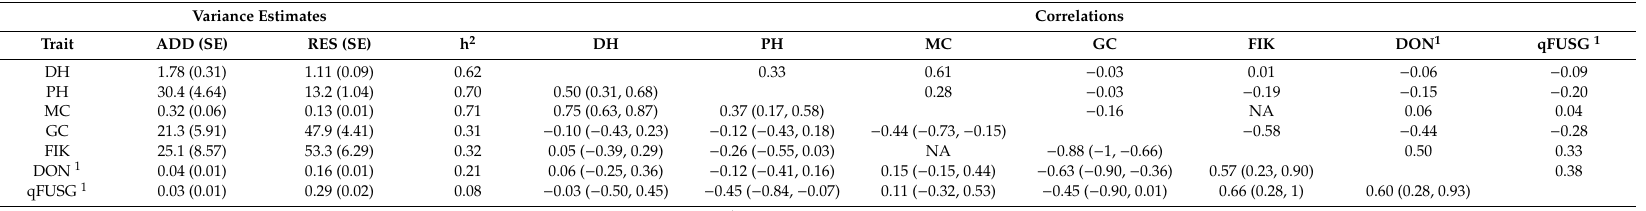
Table 3. Variance components with standard errors and narrow-sense heritabilities (h 2 ) estimated with single-trait model for each trait. ADD equals to the additive genetic variance and RES to the residual variance. Genotypic correlations with confidence interval in parenthesis are presented in the lower triangle. Phenotypic correlations are printed in the upper